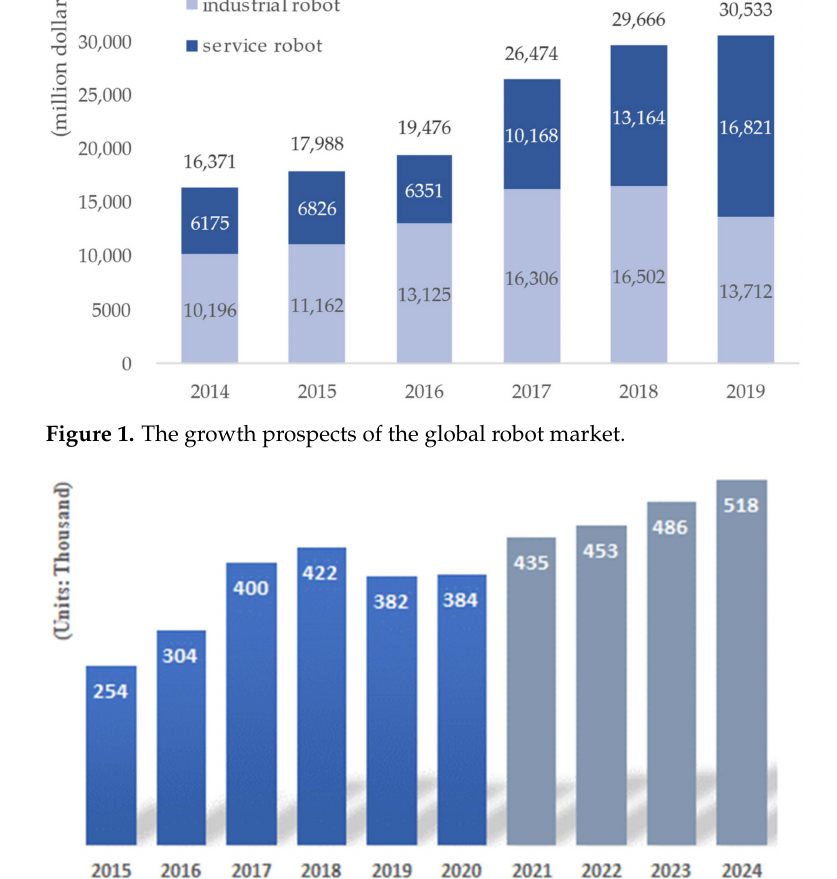
Figure 2. Number of annual installations of industrial robots.